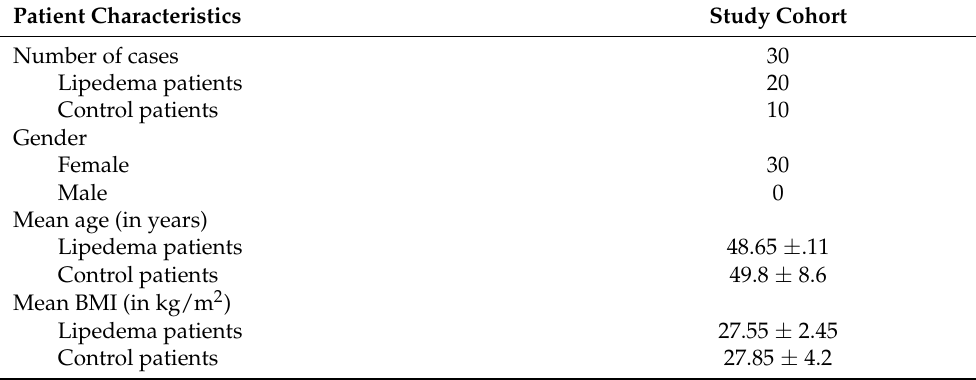
Table 1. Patient